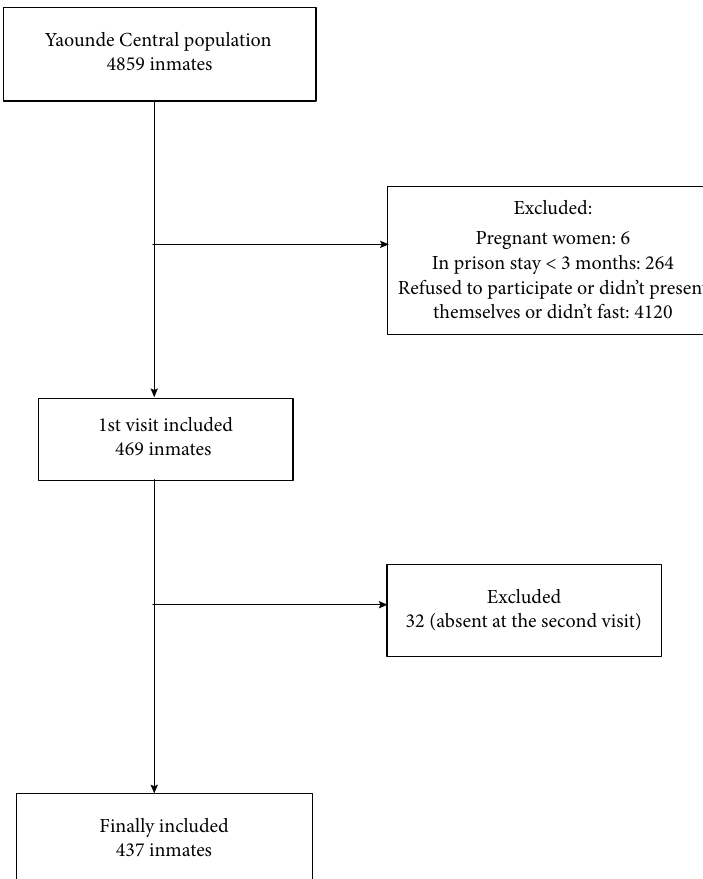
Figure 1: Patient fl ow